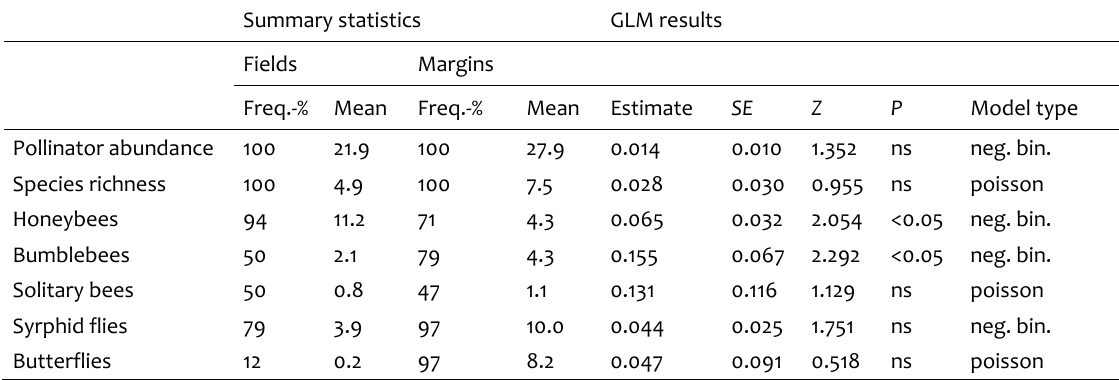
Occurrence frequency, mean abundance and species richness of pollinators in turnip rape fields and field margins, and the results of generalised linear models explaining pollinator abundance and species richness in turnip rape fields with their abundance and species richness in adjacent field margins.